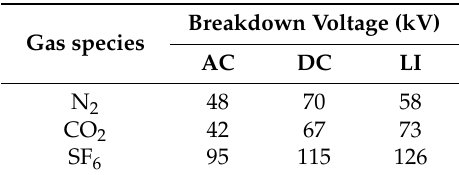
Table 1. Average breakdown voltage of N 2 , CO 2 , and SF 6 for the three voltage waveform voltages at 2 bar.